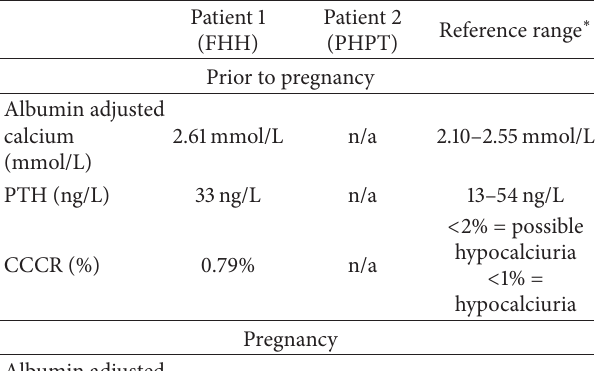
Table 1: Summary of serum and urine biochemistry in patients 1 and 2 prior to pregnancy, during pregnancy, and during